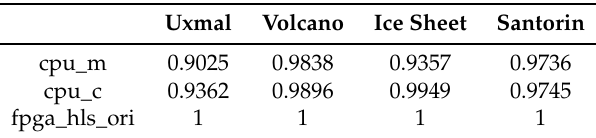
Table 4. Segmentation result similarities of the proposed and reference implementations: Evaluated by the corr2() function within